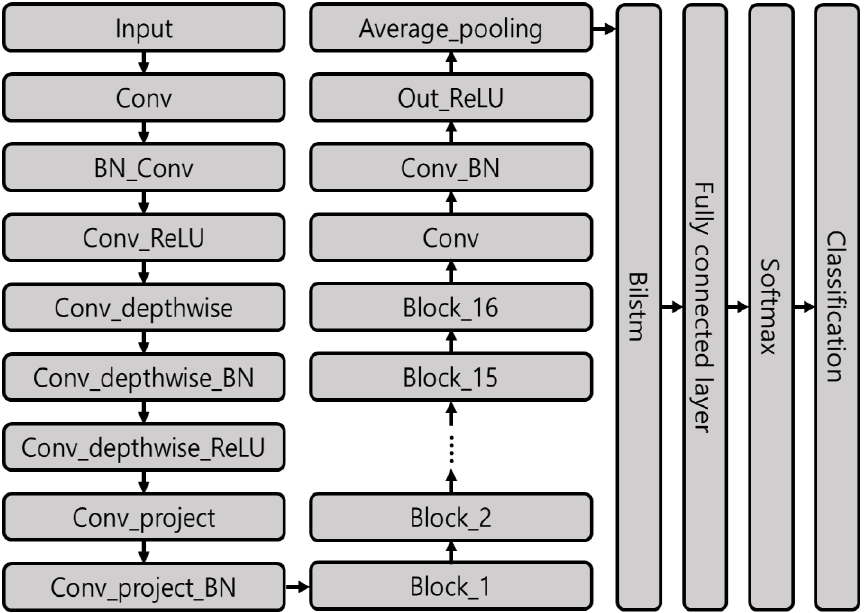
Figure 7. MobileNetV2-BiLSTM structure for classifying data. ECG data are input to BiLSTM through a convolution operation and classified in the FC layer. MobileNet V2 and BiLSTM were combined by Matlab-based Network designer.